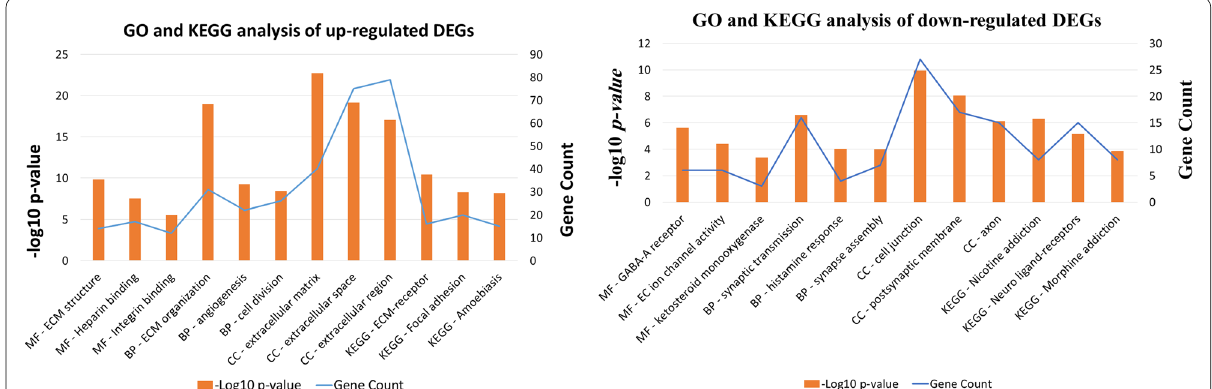
Fig. 3 Top three pathways analysis of molecular function (MF), biological process (BP) and cellular components (CC) of GO, as well as KEGG analysis results. Left; up‑regulated DEGs, Right; down‑regulated